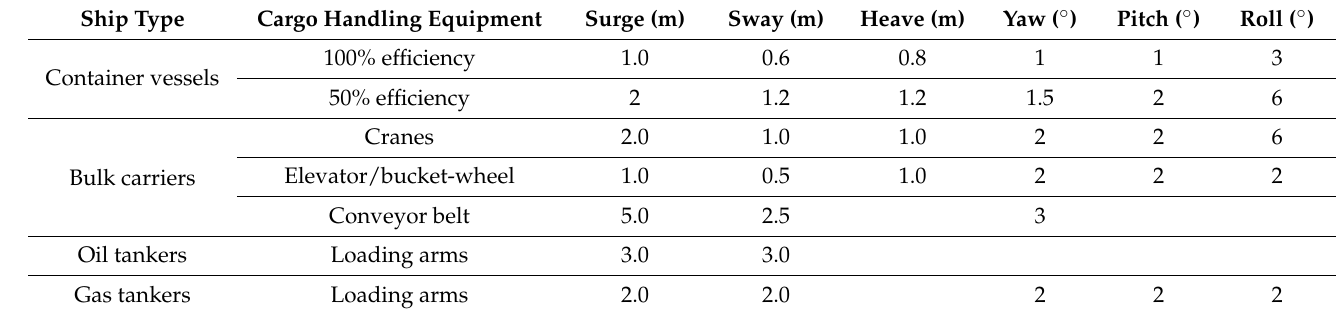
Table 5. Acceptable motion for moored ships [43].